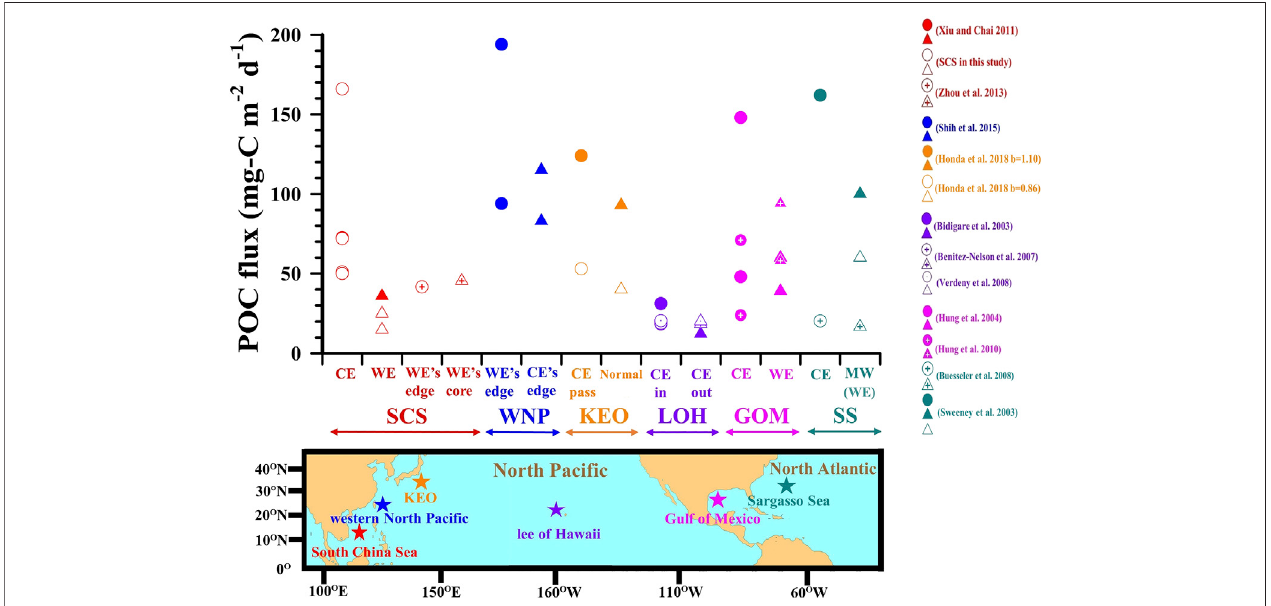
FIGURE7| POC fl uxesassociatedwitheddiesinsubtropicalregionsoftheNorthernHemisphere: SouthChinaSea(SCS),WesternNorthPaci fi c(WNP),Kuroshio Extension Observatory (KEO), Lee of Hawaii (LOH), Gulf of Mexico (GOM), Sargasso Sea (SS). POC fl uxes at KEO (Honda et al., 2018), 150-m depth, was estimated accordingtotheMartin ’ s fl uxattenuationequation,i.e.,POC fl ux (cid:2) Flux 100 (Z/100) − b (Martinetal.,1987)withbvaluesfromShihetal.(2019)andMartinetal.(1987)(1.10 and 0.86, respectively); the POC fl ux denoted by symbols of circle and triangle when CE passed and did not pass over a moored sediment trap, respectively (CE pass and Normal). POC fl uxes in the Sargasso Sea, 150-m depth, were calculated according to [POC fl ux (mg-C m − 2 d − 1 )] (cid:2) [ 234 Th fl ux (dpm m − 2 d − 1 )] × [POC/ 234 Th ( μ mol dpm − 1 )], where the fl ux of 234 Th was obtained from Sweeney et al. (2003) and an average value for [POC/ 234 Th] was obtained from the references listed in Hung etal.(2012).Relativetothereferencezoneorperiod,i.e.,trianglesymbols,circlesymbolsrepresentedthePOC fl uxwhichthehighvaluewasexpectedtobeobservedat the target zone or